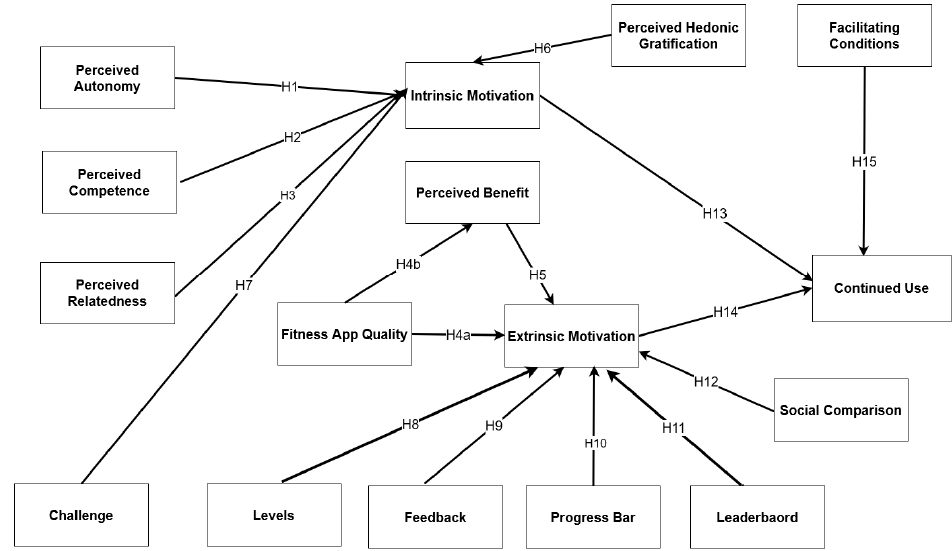
Figure 1. Proposed